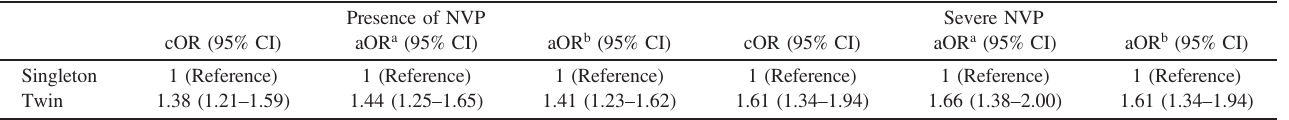
Table 3. Odds ratio of presence of NVP and severe NVP in relation to